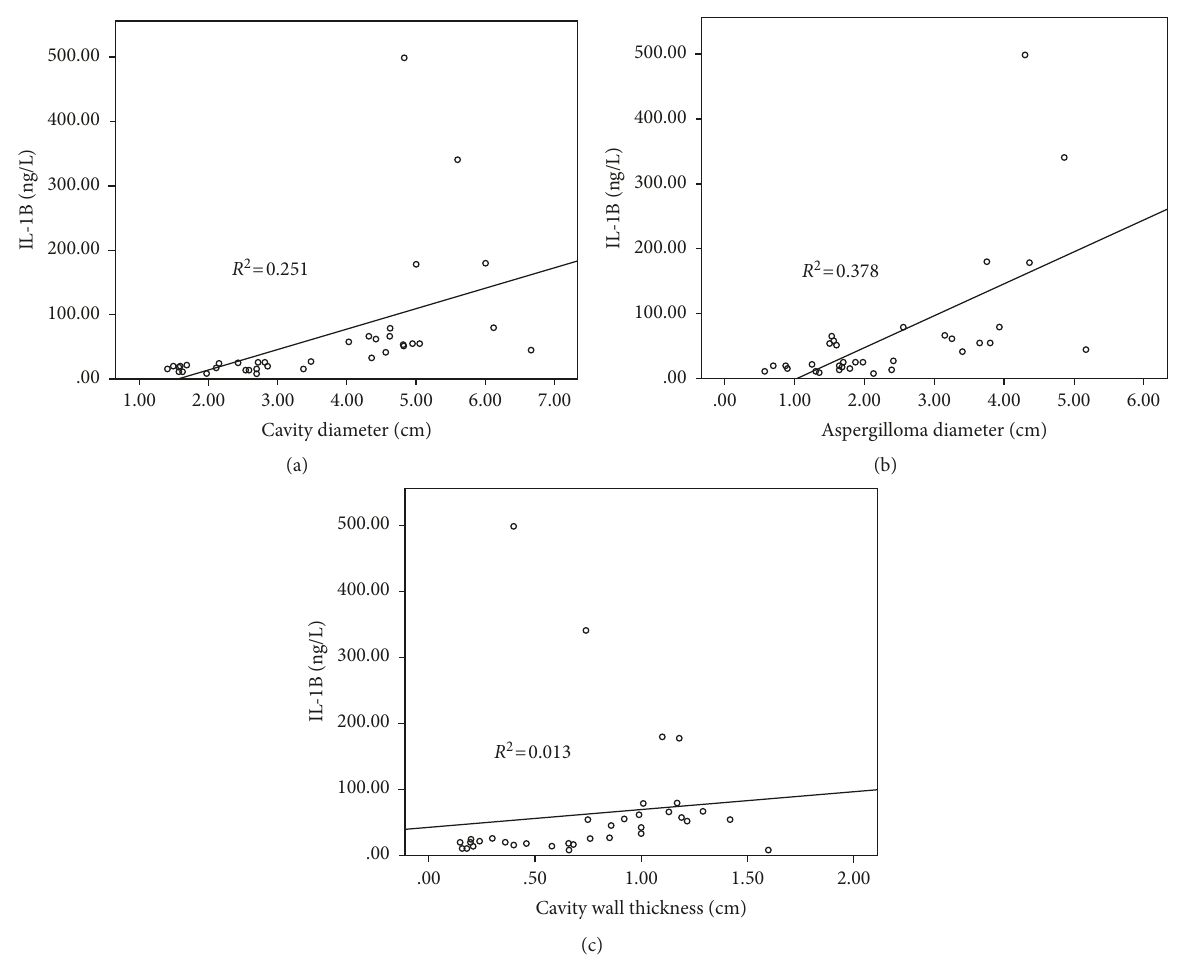
Figure 1: Trend analysis and correlation analysis found that IL-1B was correlated with the cavity diameter ( Rs aspergilloma size ( Rs